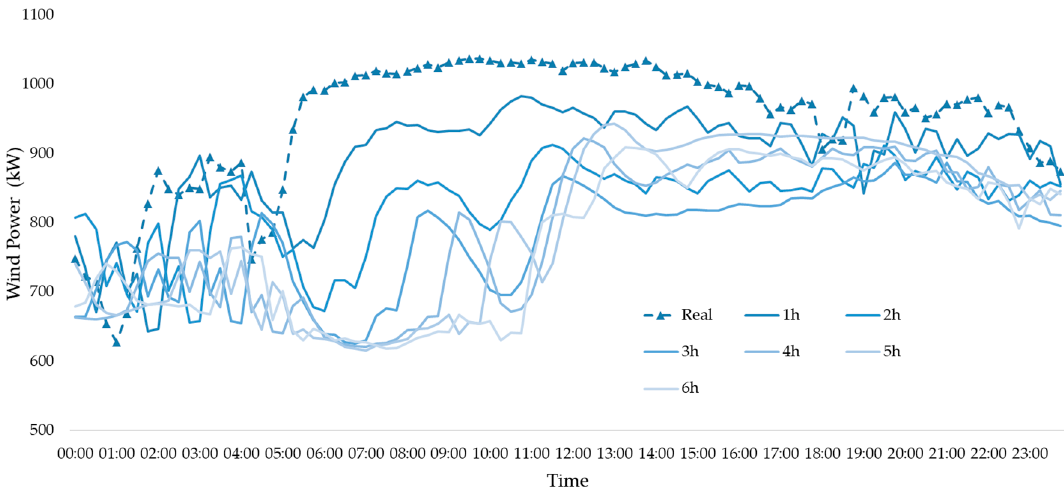
Figure 9. Prediction results of LSTM.